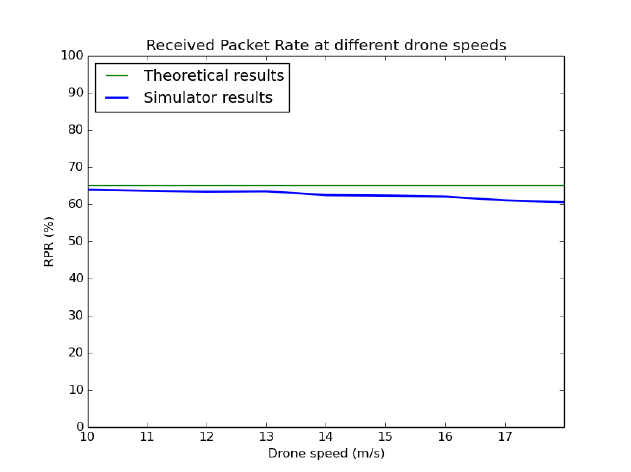
Figure 16. Received Packet Rate at different drone speeds, noise nodes = 50